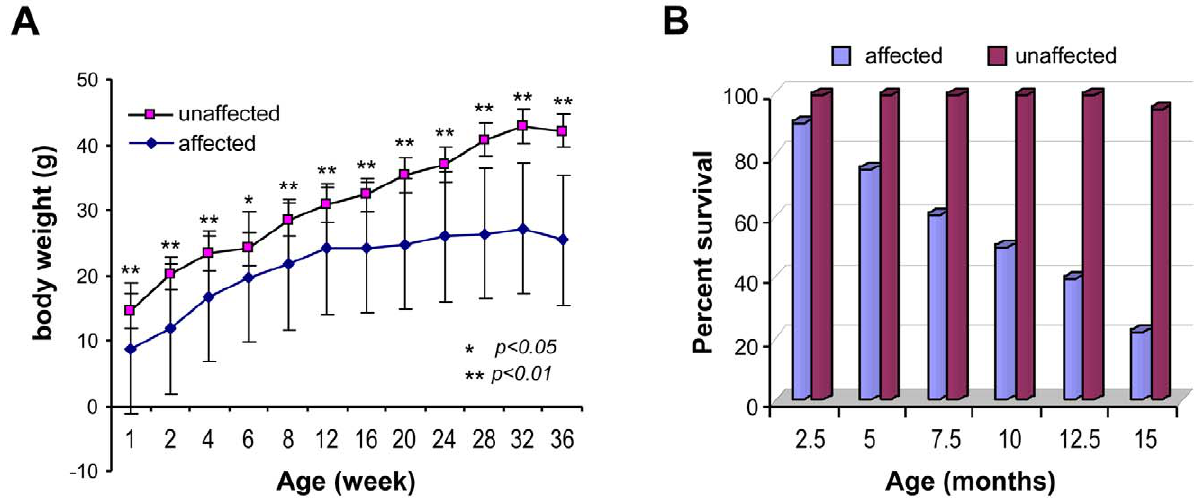
Figure 1. Body weight and life span of the affected mice. (A) Body weights of affected male mice compared to their unaffected male siblings (n=10 each). Values are expressed as mean 6 SE. (B) Life span of the affected mice compared to their unaffected siblings (n=10 each).